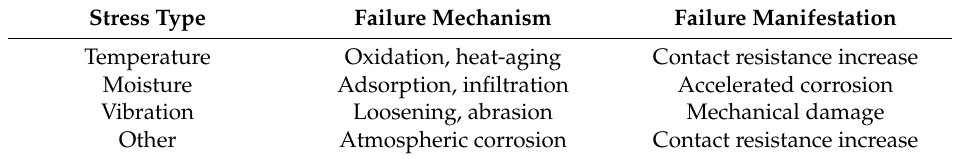
Table 1. Mechanism and manifestation of failures of electromagnetic relays under single environmental